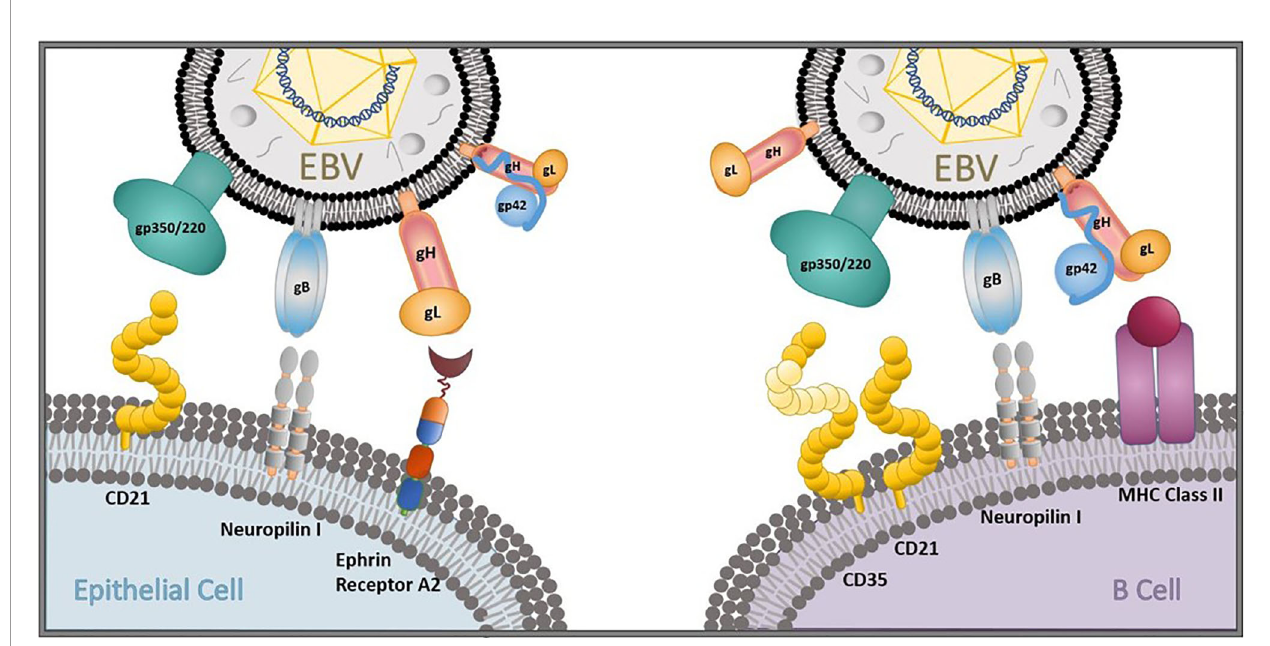
FIGURE 1 | EBV entry and infection of primary target cells. The EBV glycoproteins gp350/220 (gp350), gB, gp42, and the gH/gL complex are important for viral entry into epithelial cells and B cells. gp350 binds to CD21 on epithelial cells and CD35/CD21 on B cells. gB and gH/gL attach to neuropilin 1 and ephrin receptor A2, respectively, on oropharyngeal epithelial cells to gain viral entry, and gB interacts with neuropilin 1 on B cells. gp42 forms a complex with gH/gL that binds to MHC class II to gain viral entry into B cells in collaboration with